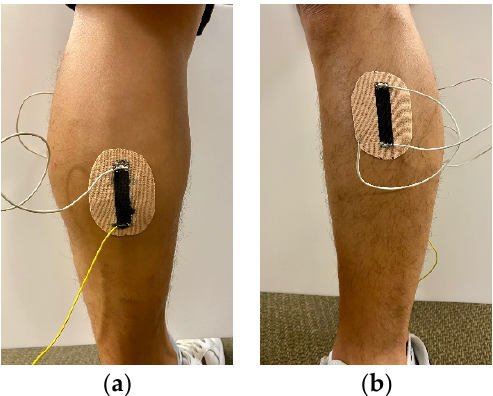
Figure 3. ( a ) Motion Tapes were mounted to a subject’s calf and ( b ) tibialis anterior.